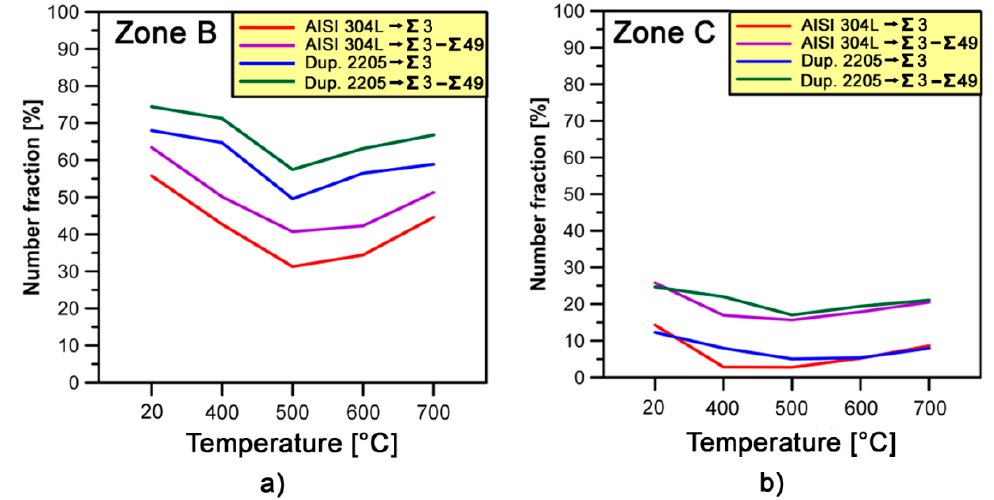
Figure 16. Fractions of CSL boundaries in γ -phase estimated at different forging temperatures: ( a ) zone A ; and ( b ) zone C .